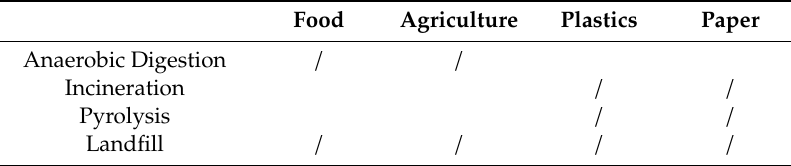
Table 5. Waste allocation to conversion technology.